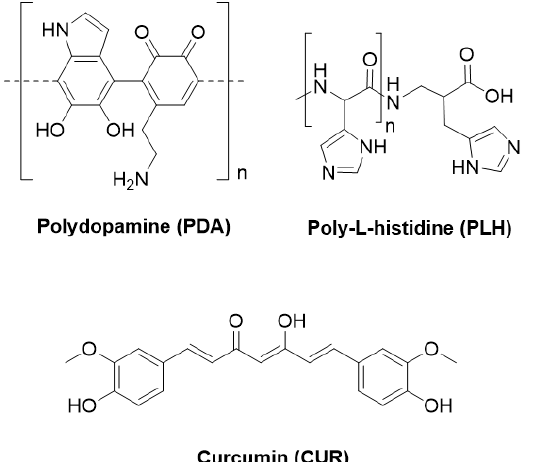
Figure 13. Chemical structure of Polydopamine, Poly-L-histidine, and curcumin.